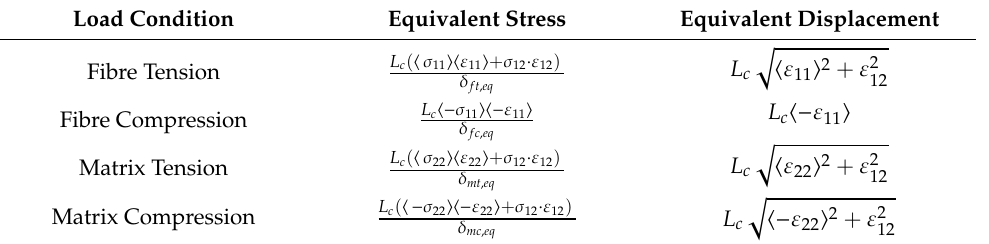
Table 1. Equivalent stress and displacement